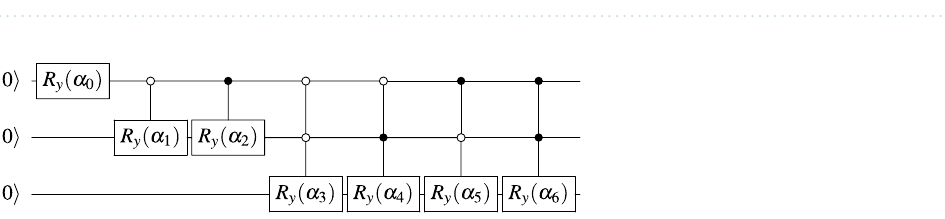
Figure 1. Data representation of information in function generate angles.